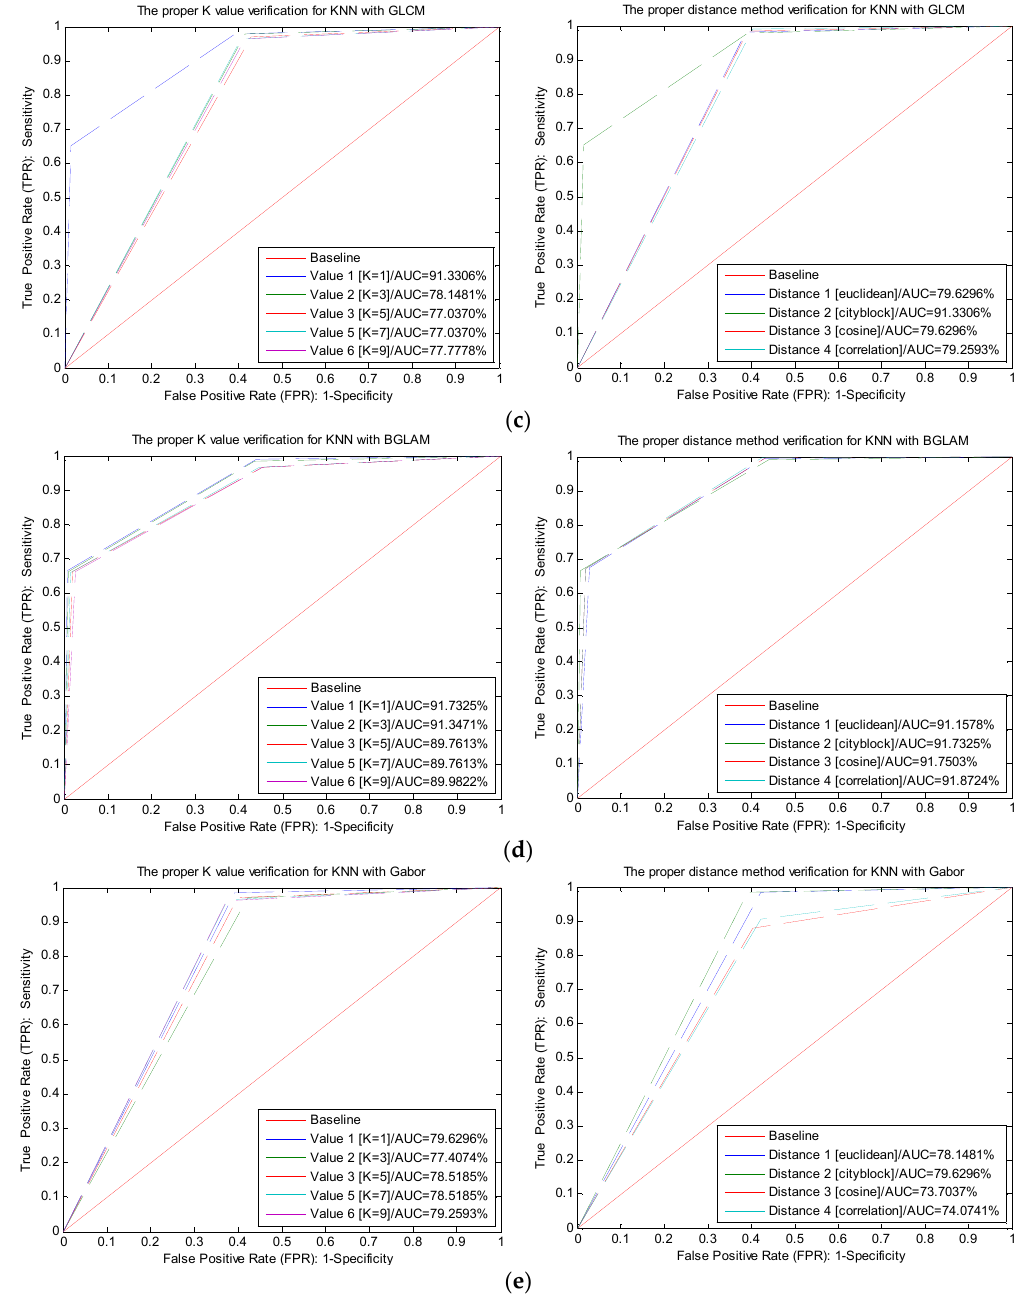
Figure 14. K-value and distance metric for KNN and feature extraction techniques: ( a ) statistical, ( b ) histogram, ( c ) GLCM, ( d ) BGLAM and ( e ) Gabor.